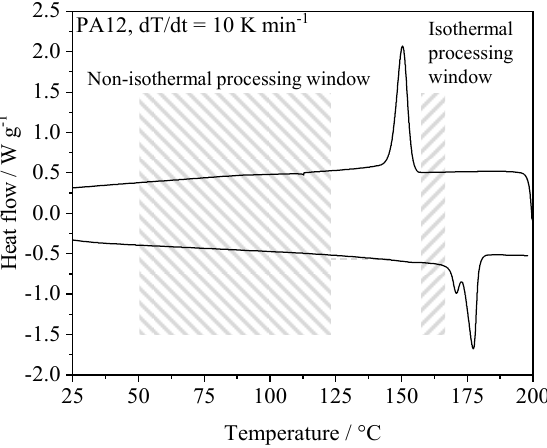
Figure 1. Schematic illustration of process-dependent thermal processing windows.